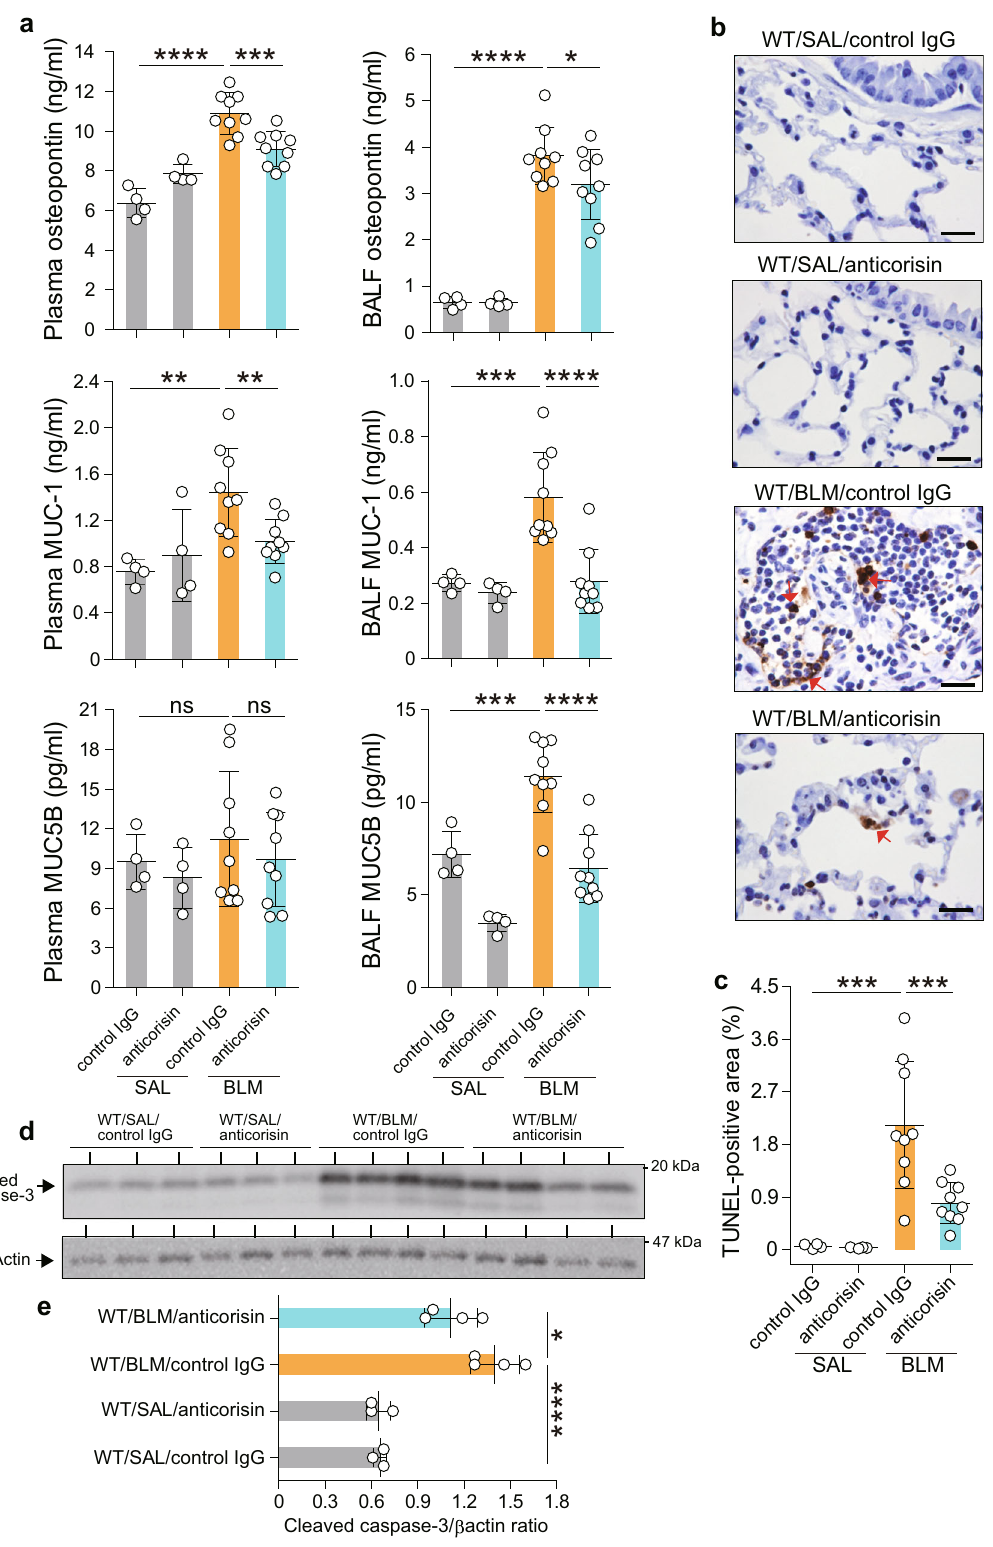
survival was followed. The TGF β 1 TG mice with lung fi brosis and BLM-induced AE treated with the anticorisin mAtb showed sig- ni fi cantly longer survival than those treated with the control IgG (Supplementary Fig. 30c). As expected, the control groups receiving saline through osmotic mini-pumps showed no changes in